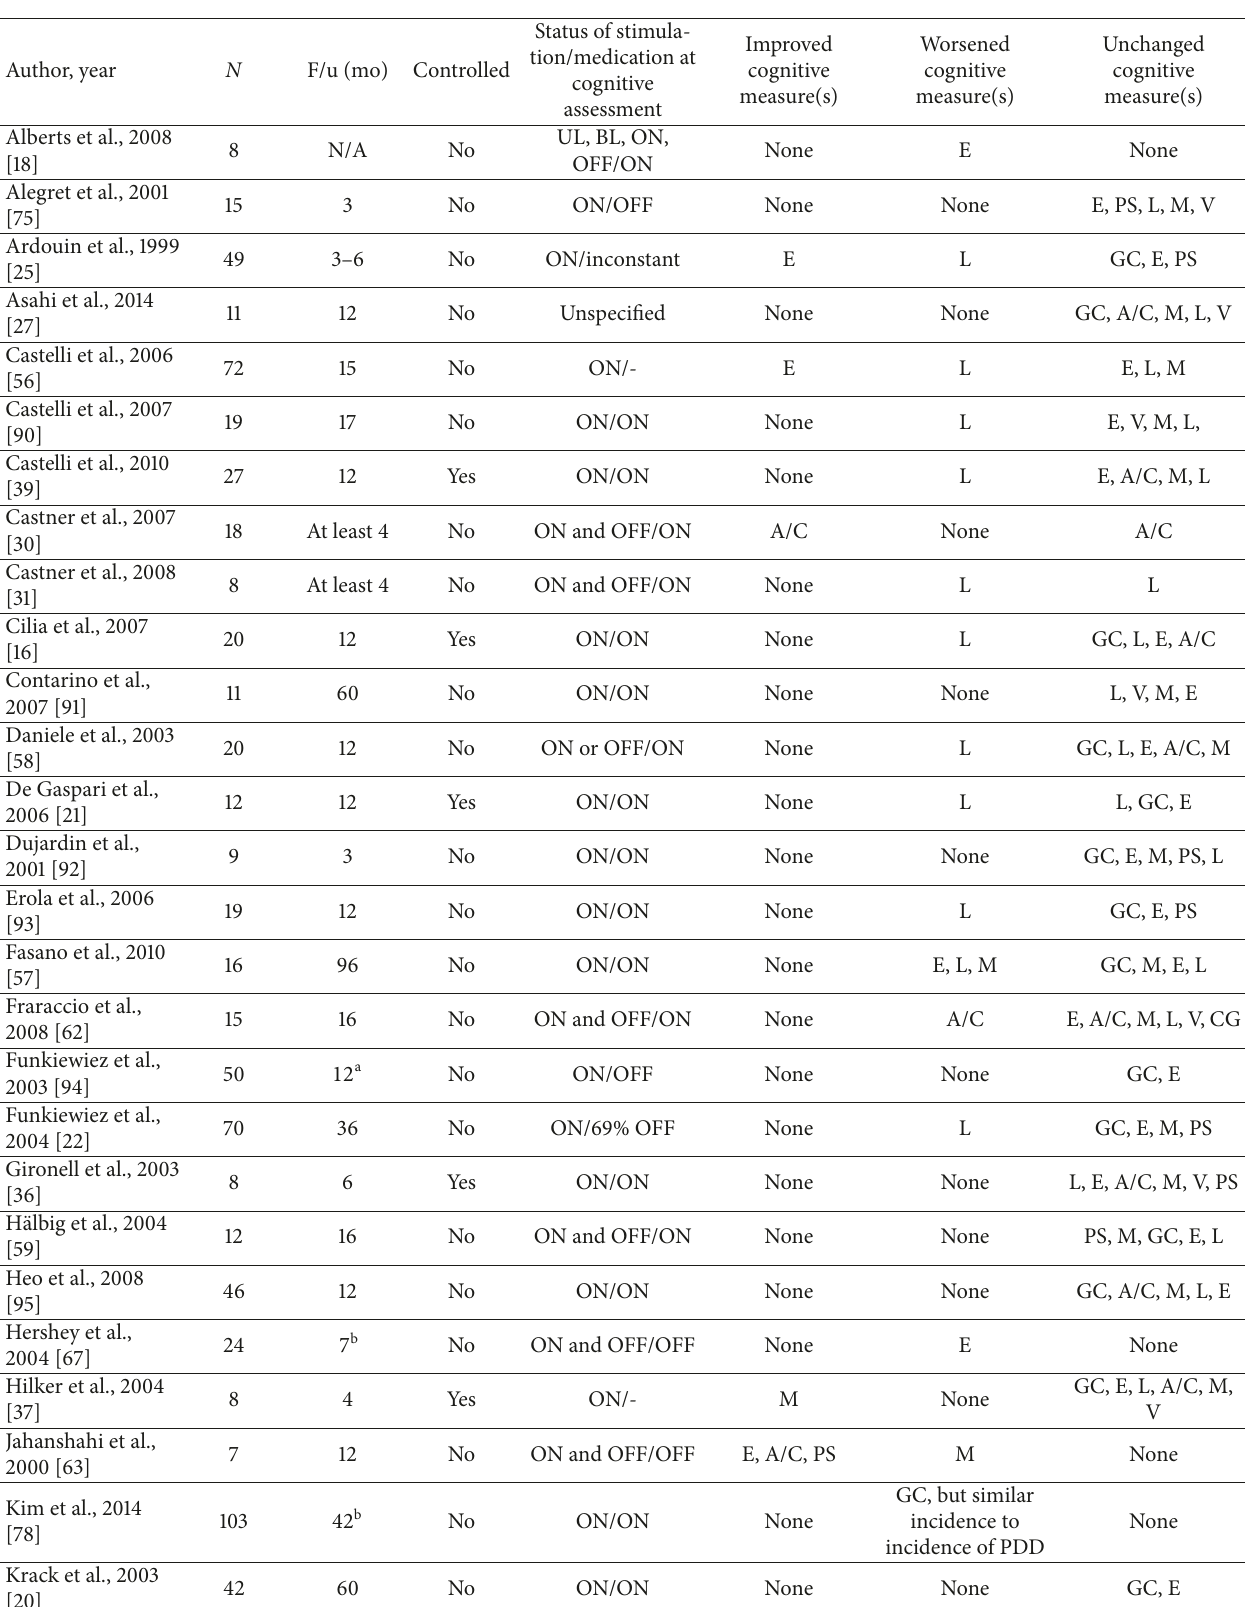
Table 1: Studies assessing cognitive change in PD patients after STN